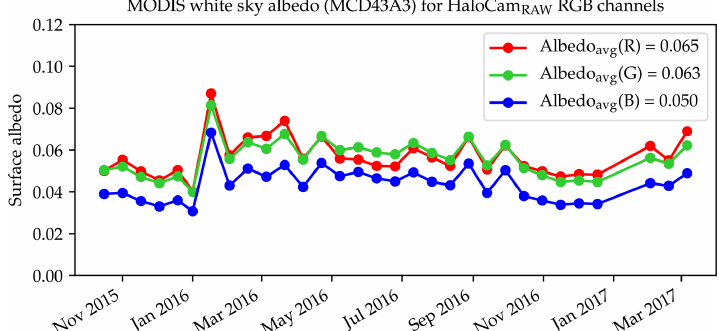
Figure B7. Surface albedo between October 2015 and March 2017 for the HaloCam RAW RGB channels. The data are obtained by weighting the spectral high-resolution parameterization of the MODIS albedo data (cf. Fig. B6, black curve) with the spectral response of the RGB channels (Forster et al., 2020). The surface albedo for the HaloCam RAW channels averaged over this period amounts to 0.065 (R), 0.063 (G), and 0.050